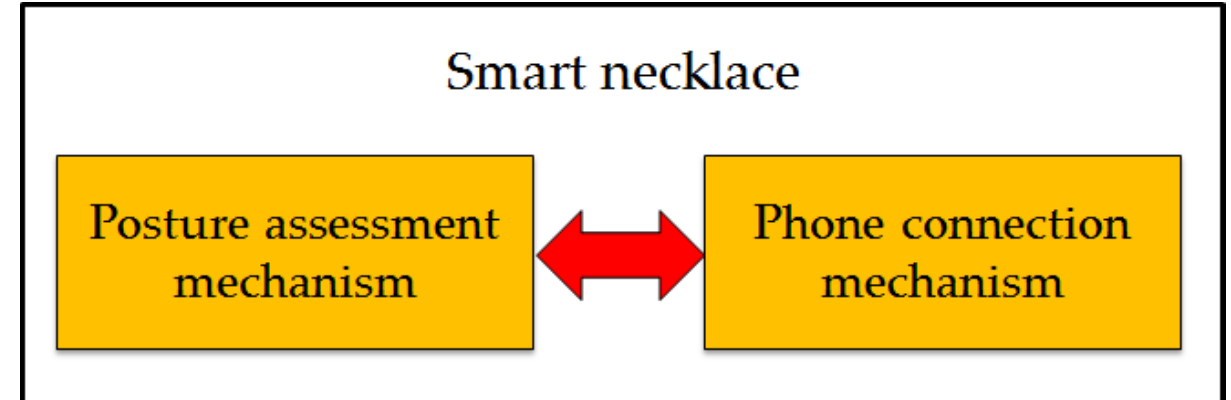
Figure 5. Two mechanisms of the smart necklace, namely, the posture assessment and phone connection mechanisms, responsible for performing posture assessments and sending reminder signals to the smart phone, respectively.